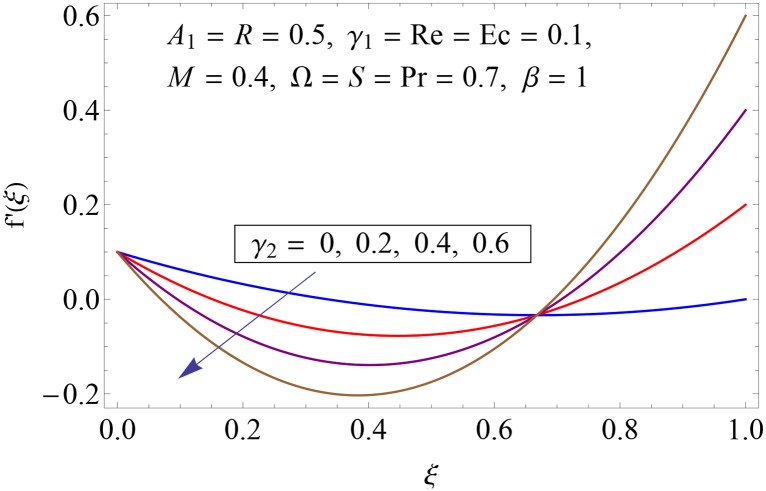
Impact of γ2 on f′(ξ).